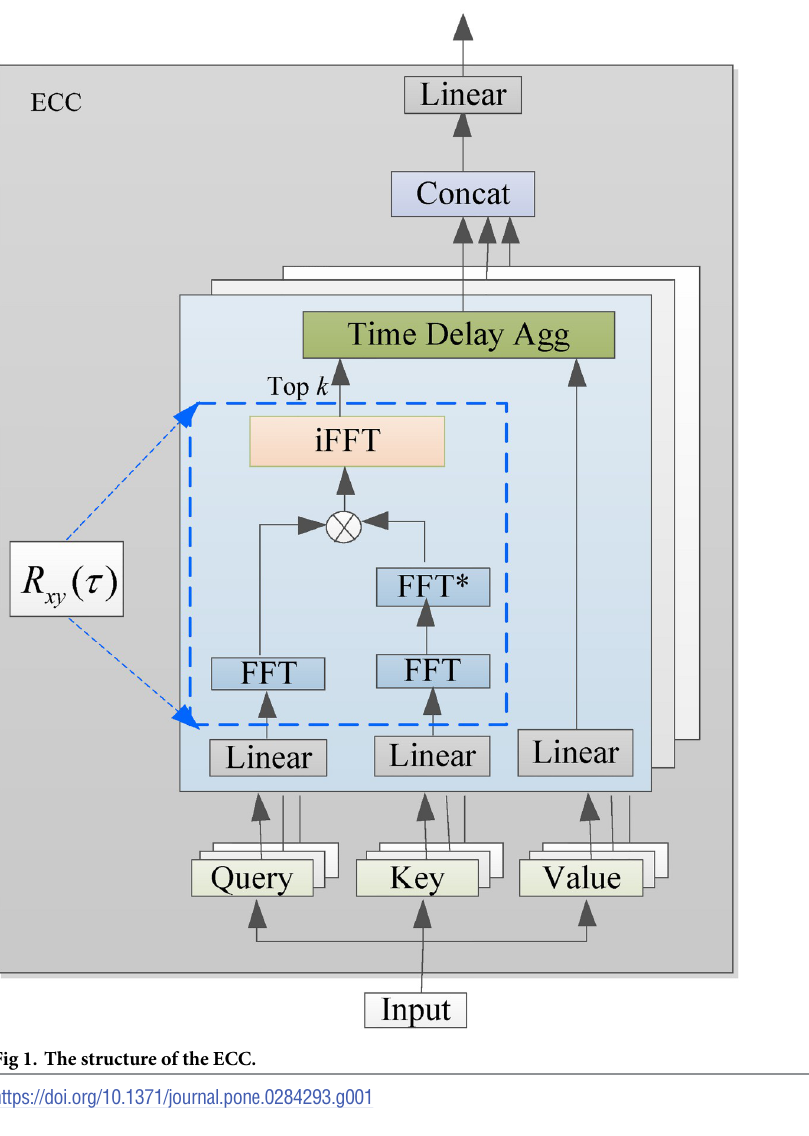
Fig 1. The structure of the